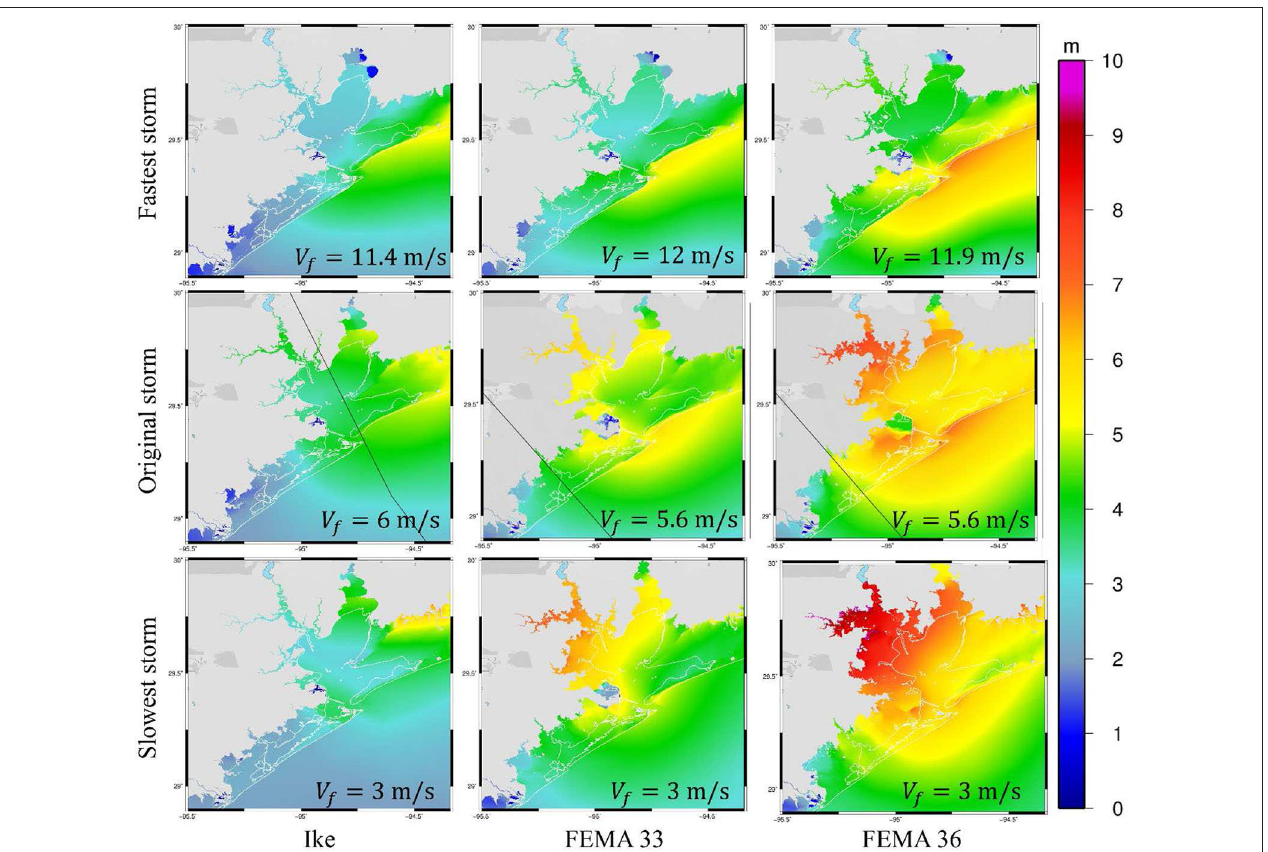
FIGURE 5 | Maximum water elevations for the baseline, slowest and fastest hurricane scenarios (SLR = 0cm).